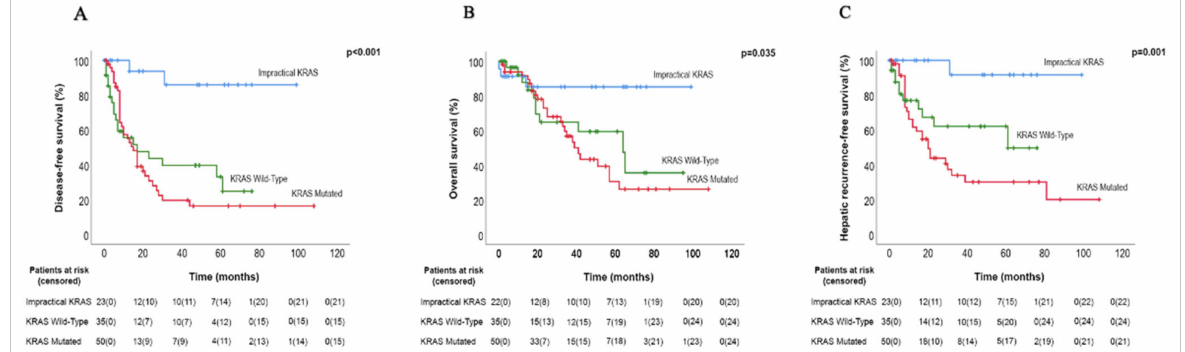
KRAS mutated versus Impractical KRAS tumours. ( B ) The overall survival (OS) rate is shown for patients with KRAS wild-type versus KRAS mutated versus Impractical KRAS tumours. ( C ) The hepatic recurrence rate is shown for patients with KRAS wild-type versus KRAS mutated versus Impractical KRAS tumours. Truncates at 120 months. 95% CI indicates 95% confidence